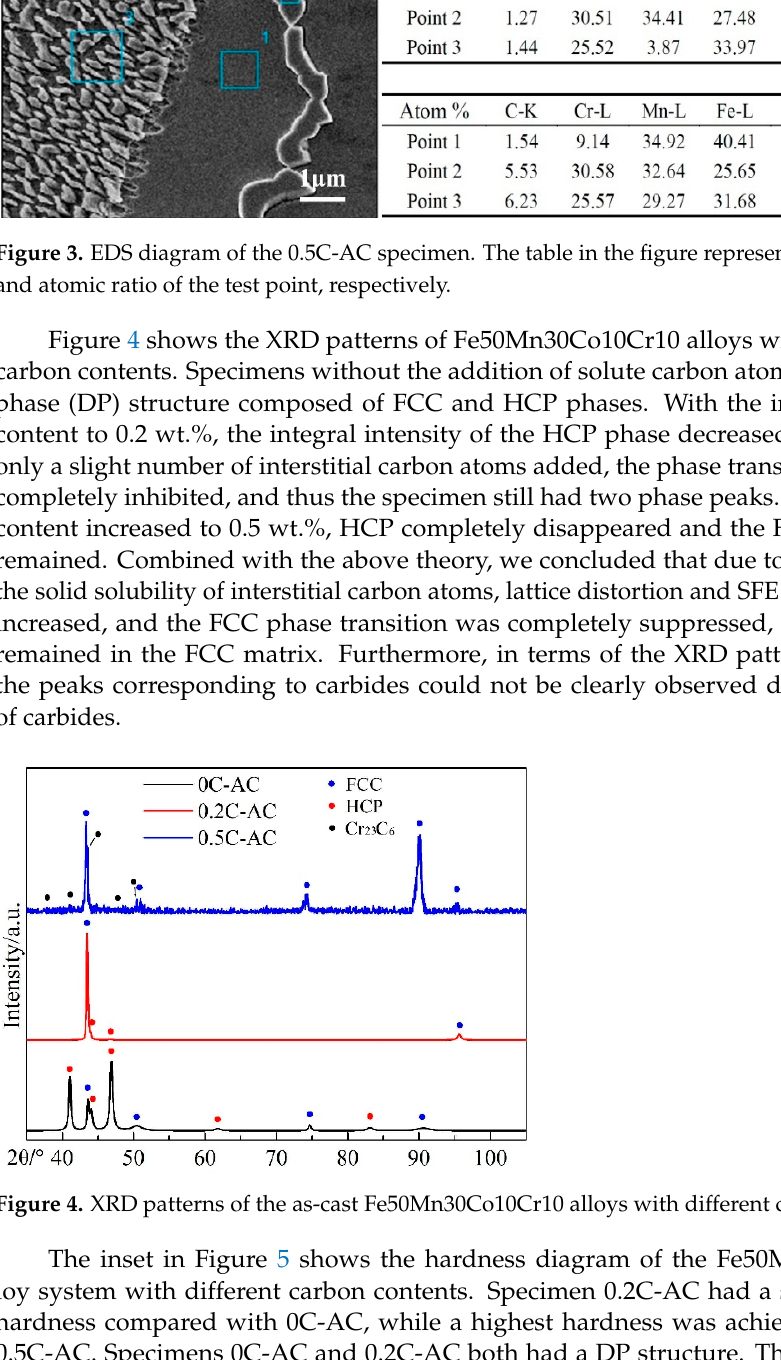
Figure 4. XRD patterns of the as-cast Fe50Mn30Co10Cr10 alloys with different carbon